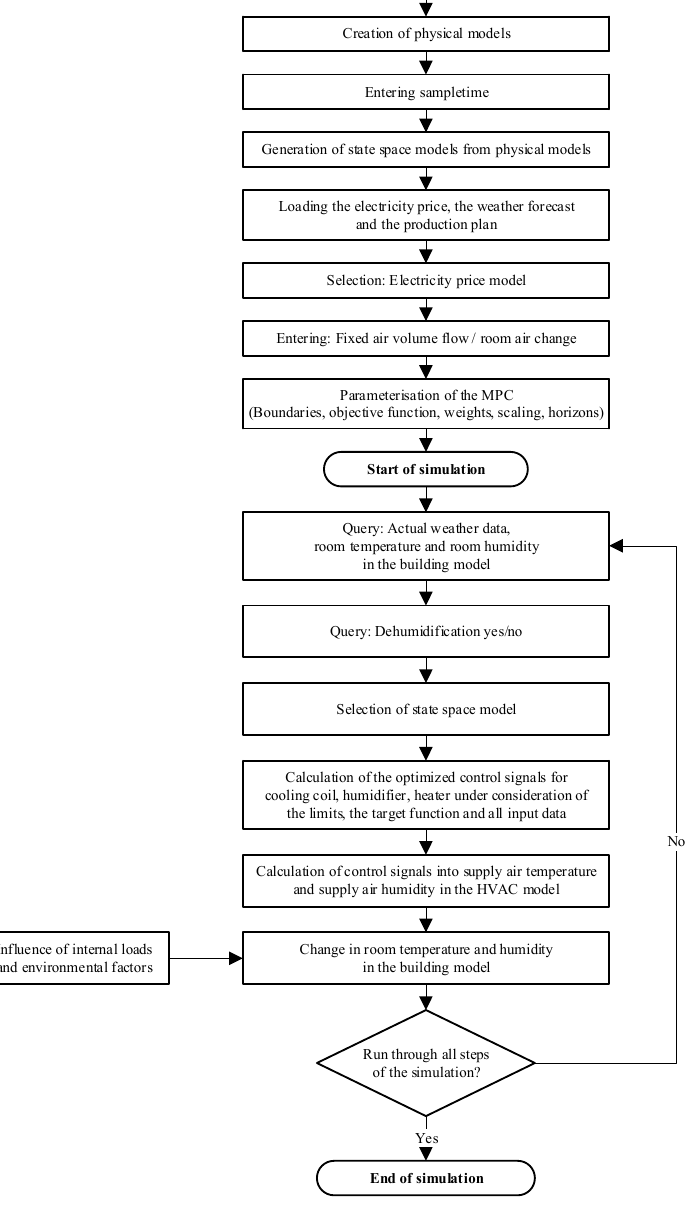
Figure 2. Flow chart—from configuration of the MPC to simulation run.